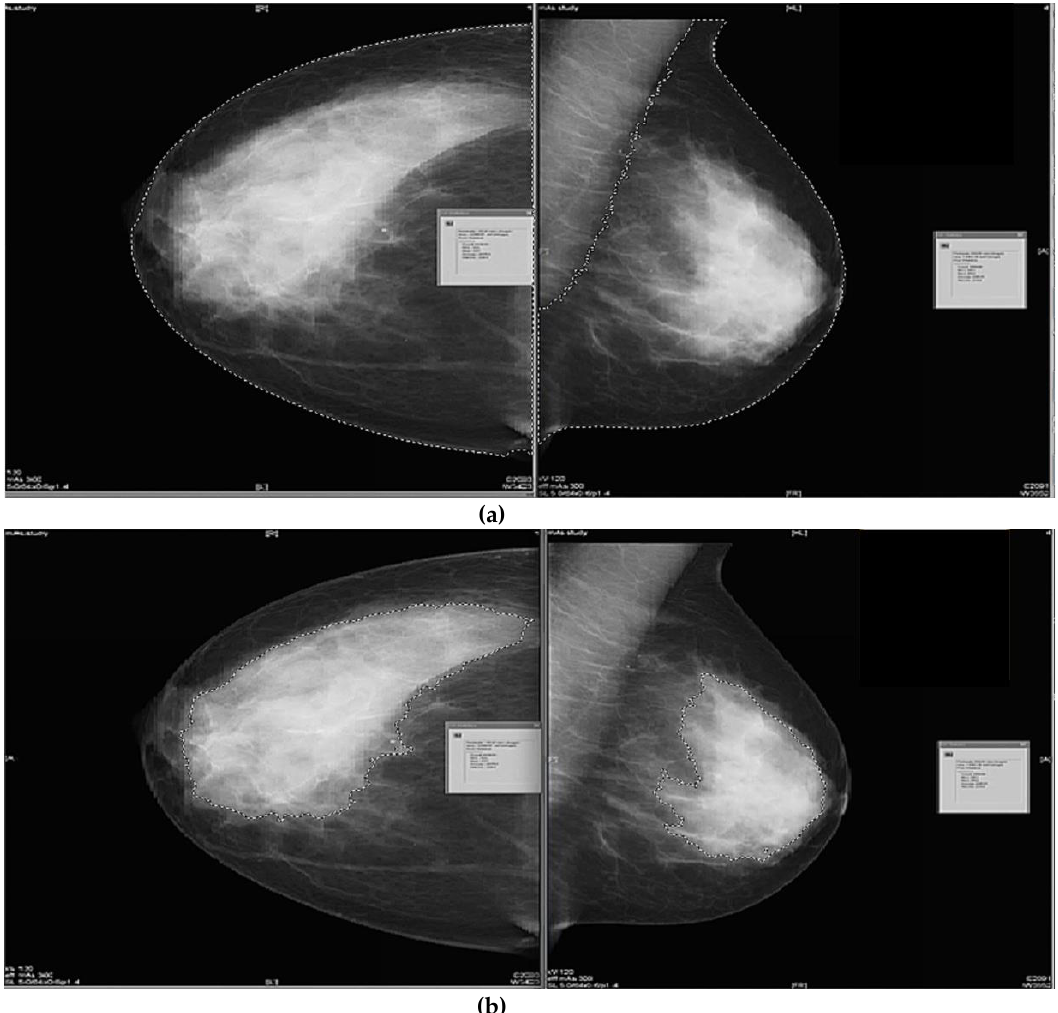
Figure 1. ( a ). Screen shot of the semi-subjective (HD) method showing the craniocaudal and mediolateral oblique breast images with boundaries drawn around the outer surface of the breast. ( b ). Screen shot of the semi-subjective (HD) software showing the craniocaudal and mediolateral oblique breast images with boundaries drawn around the fibroglandular tissue within the breast.